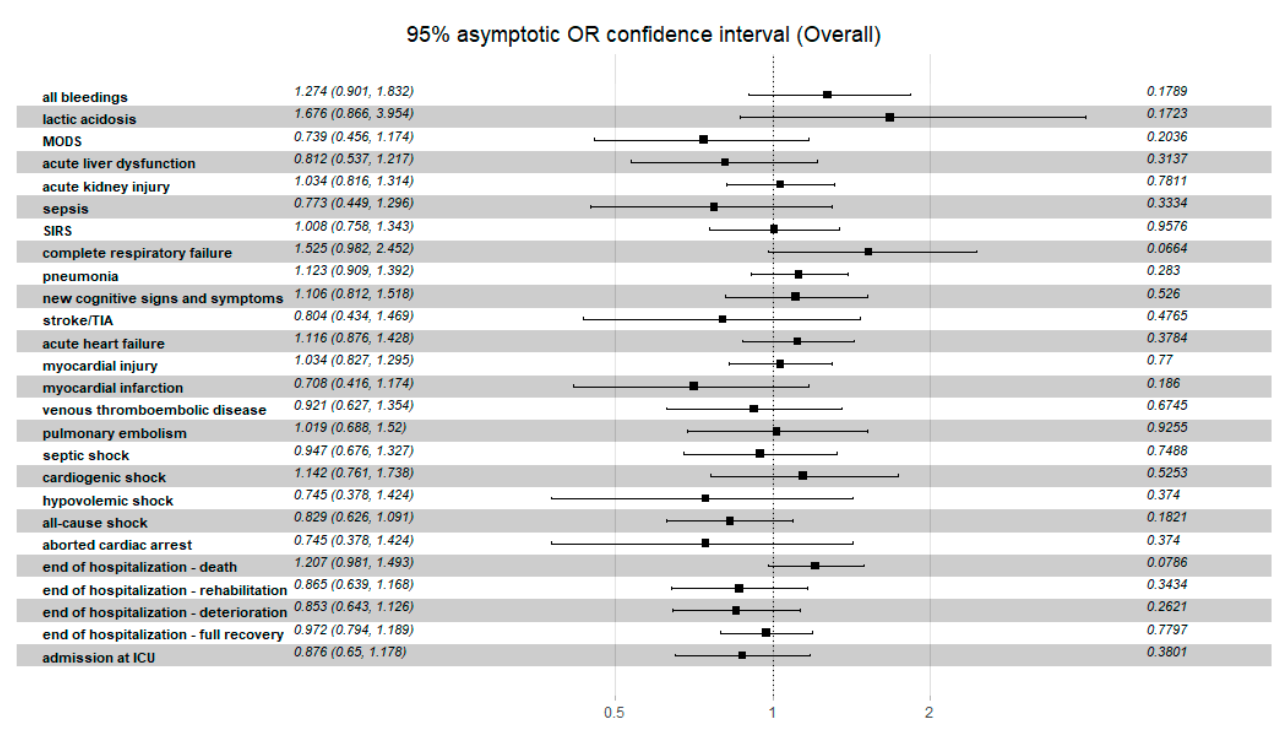
Figure 5. The overall odds ratio for the discriminatory performance of the C 2 HEST score on clinical non-fatal events in the HF cohort. Abbreviations: MODS—multiple organ dysfunction syndrome, TIA—transient ischemic attack, SIRS—systemic inflammatory response syndrome.